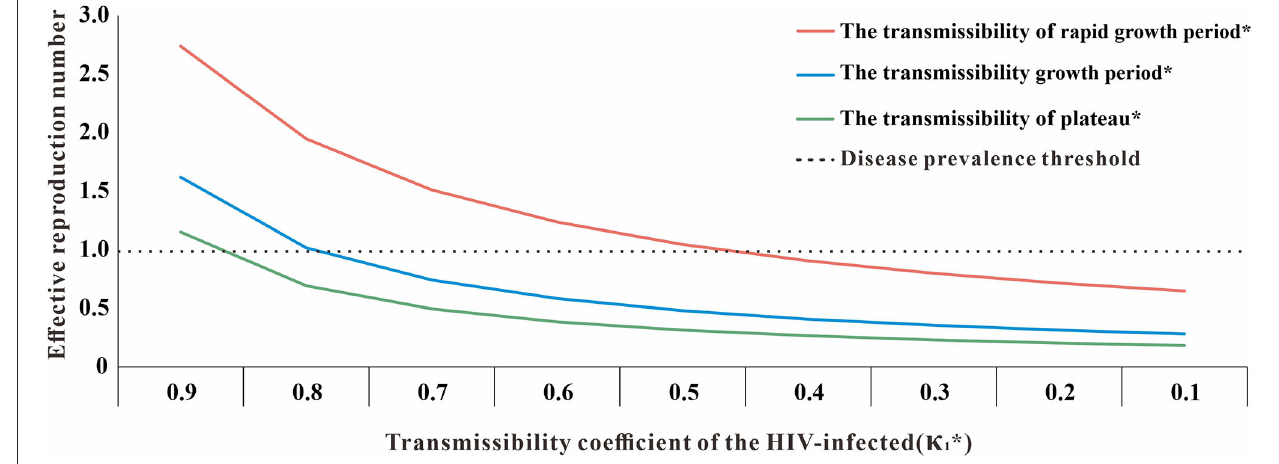
FIGURE 10 | The sensitivity analysis of κ 1 (* κ 1 : transmissibility coefficient of the HIV-infected, κ 1 + κ 2 =